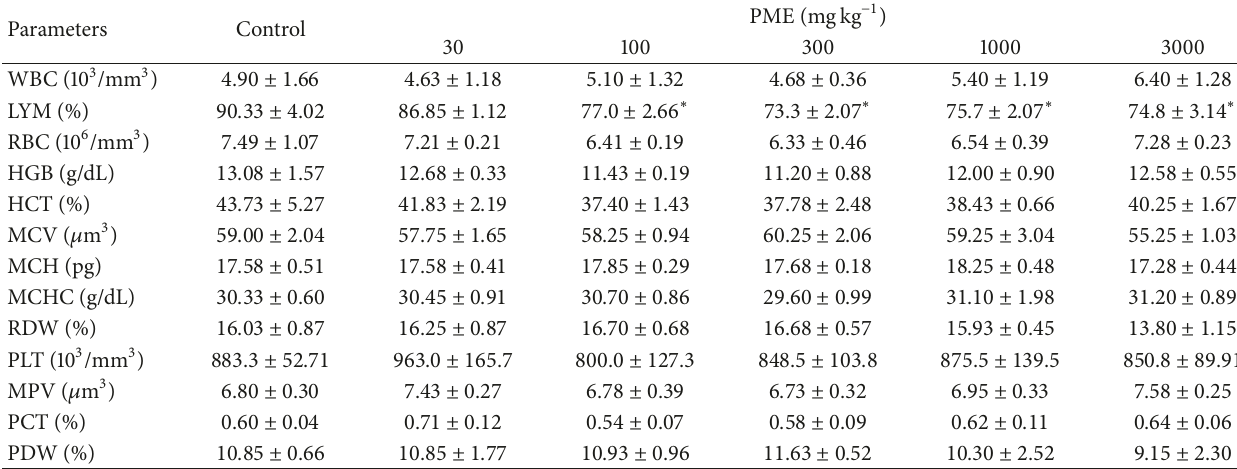
Table 3: Effect of 14-day treatment with PME on haematological parameters in rats.